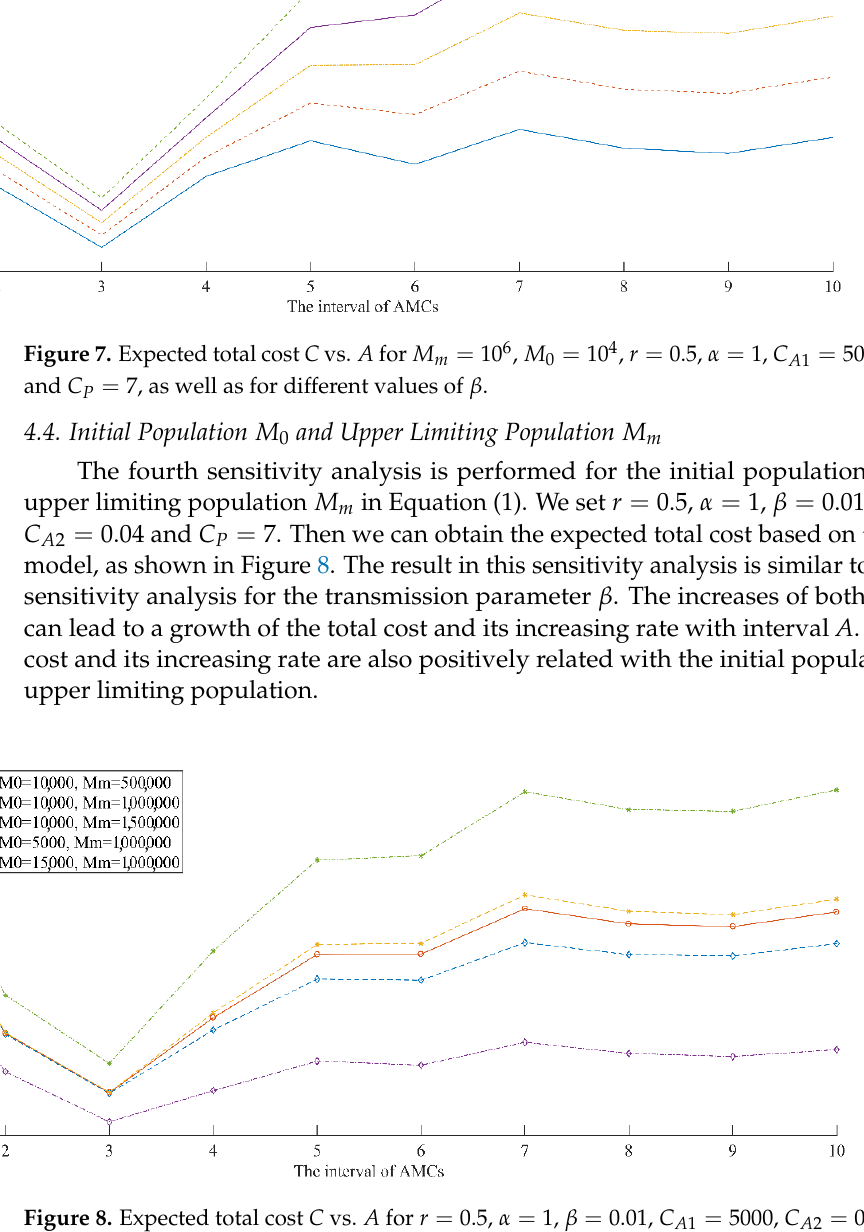
Figure 8. Expected total cost C vs. A for r = 0.5, α = 1, β = 0.01, C A 1 = 5000, C A 2 = 0.04, C P = 7, as well as for different values of M m and M 0